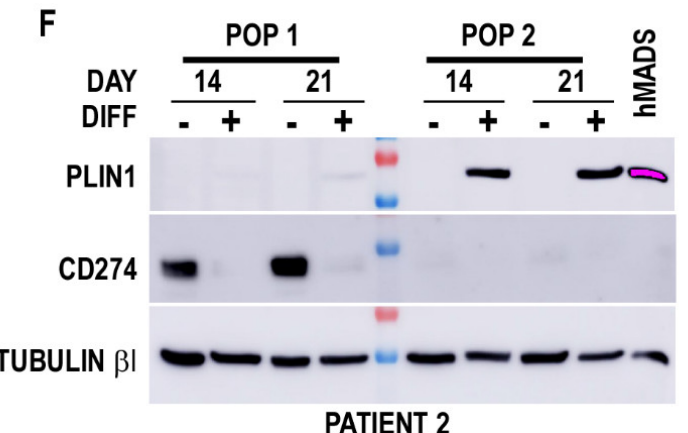
Figure 4. Expression of CD274 in the two breast adipose progenitor cell (APC) populations. ( A ) Expression of TGF-R1 and TNF receptors in cells of the two APC populations. Expression of TGF-RI and TNR receptors was assessed by real-time RT-PCR and normalized for the expression of 36B4 mRNA. The means ± SEMs were calculated from three independent experiments, with determinations performed in duplicate (* p < 0.05). ( B ) The effect of distinct cytokines on myofibroblast differentiation protein expression was measured in Population 1 of breast APCs submitted to 10 ng/mL of TGF β , TNF α , IFN γ , or IL1 β for 3 days. Expressions of α SMA, CD274, and Tubulin- β I (used as a loading control) were measured by SDS–PAGE. Expressions of the proteins were analyzed by Western blot, using specific antibodies. Representative Western blots are shown. ( C , D ) TNF α dose-dependently increases CD274 expression. Protein expression was measured in the two populations of breast APCs submitted to increasing concentrations of TNF α for 3 days. Expressions of CD274 and Tubulin- β I was used as a loading control were measured by SDS–PAGE. Expressions of the two proteins were analyzed by Western blot, using specific antibodies. Representative Western blots are shown. ( E ) Quantification of the signals. Protein expression was quantified by using FIJI program and compared to the expression of Tubulin- β I. The means ± SEMs were calculated from five independent experiments (* p < 0.05, ** p < 0.01, and *** p < 0.001). ( F ) Analysis of CD274 expression in differentiated cells. Protein expression was measured in the two populations of breast APCs grown in differentiation medium for 14 or 21 days. Expressions of PLIN1 (upper panel), CD274 (intermediate panel), and Tubulin- β I (used as a loading control) (lower panel) were analyzed by Western blot, using specific antibodies. Representative Western blots are